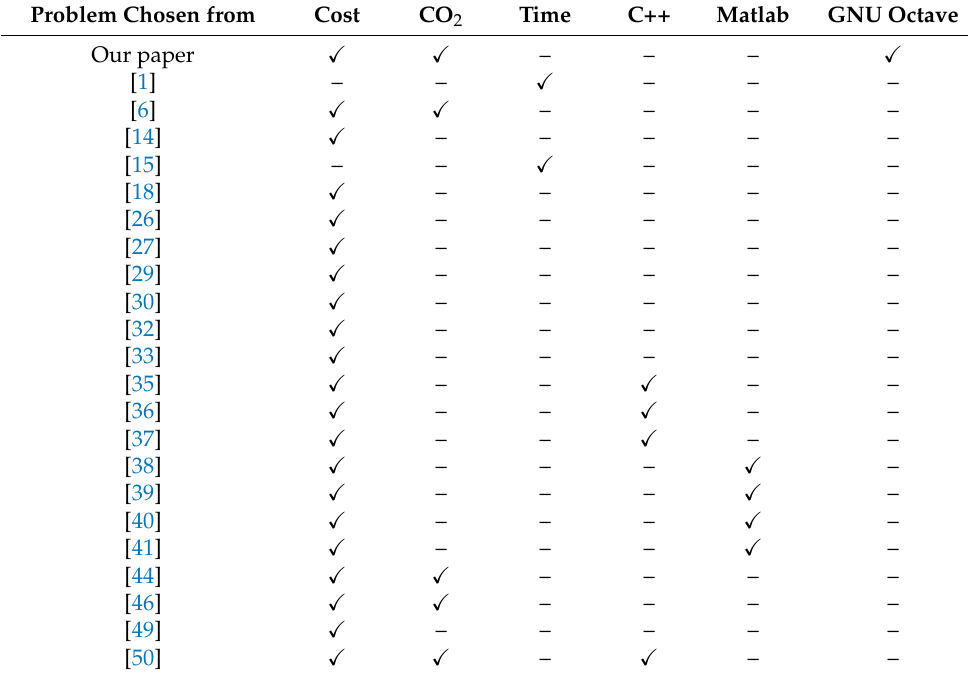
Table 1. Comparison of transportation problems in this paper and related articles. Problem Chosen from Cost CO